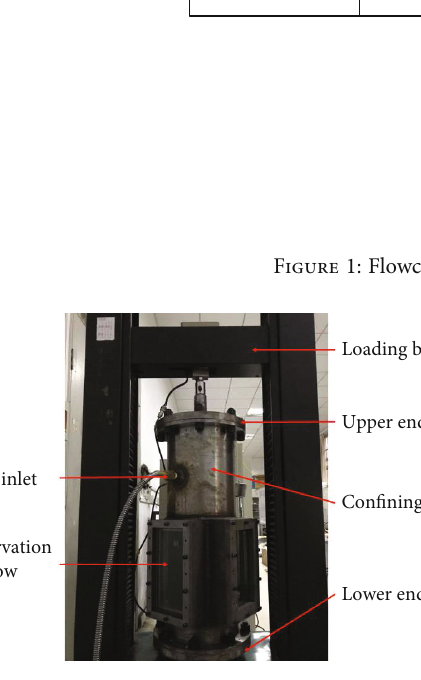
Figure 2: Physical diagram of the con fi ning pressure device. Table 1: N15 Solid propellant base